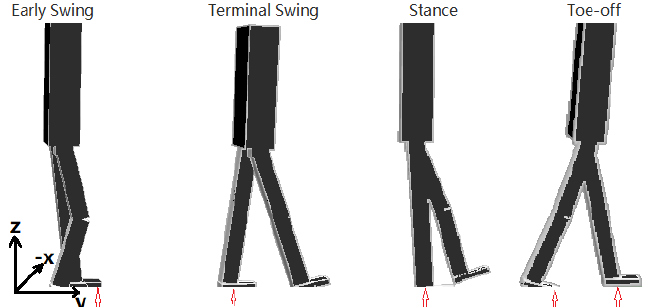
Figure 1. Simplified gait cycle for the right leg. Red arrows indicate which foot is contacting the